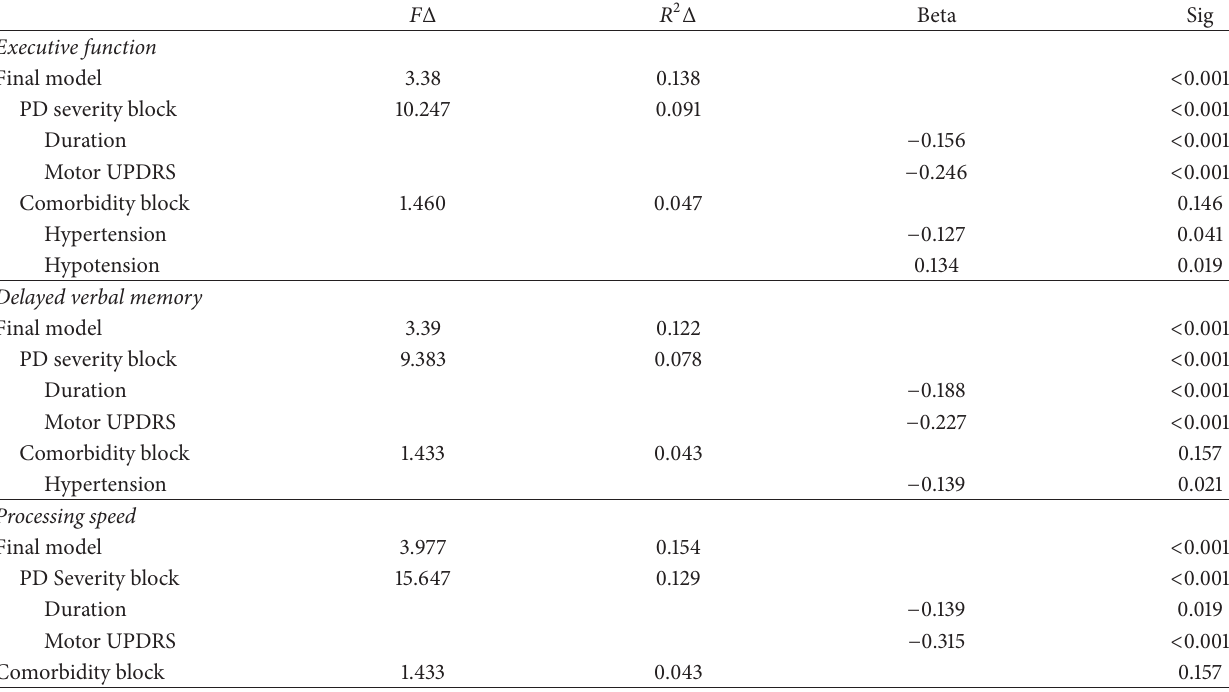
Table 3: Comorbidities and cognitive domains: summary of results of hierarchical multiple regression